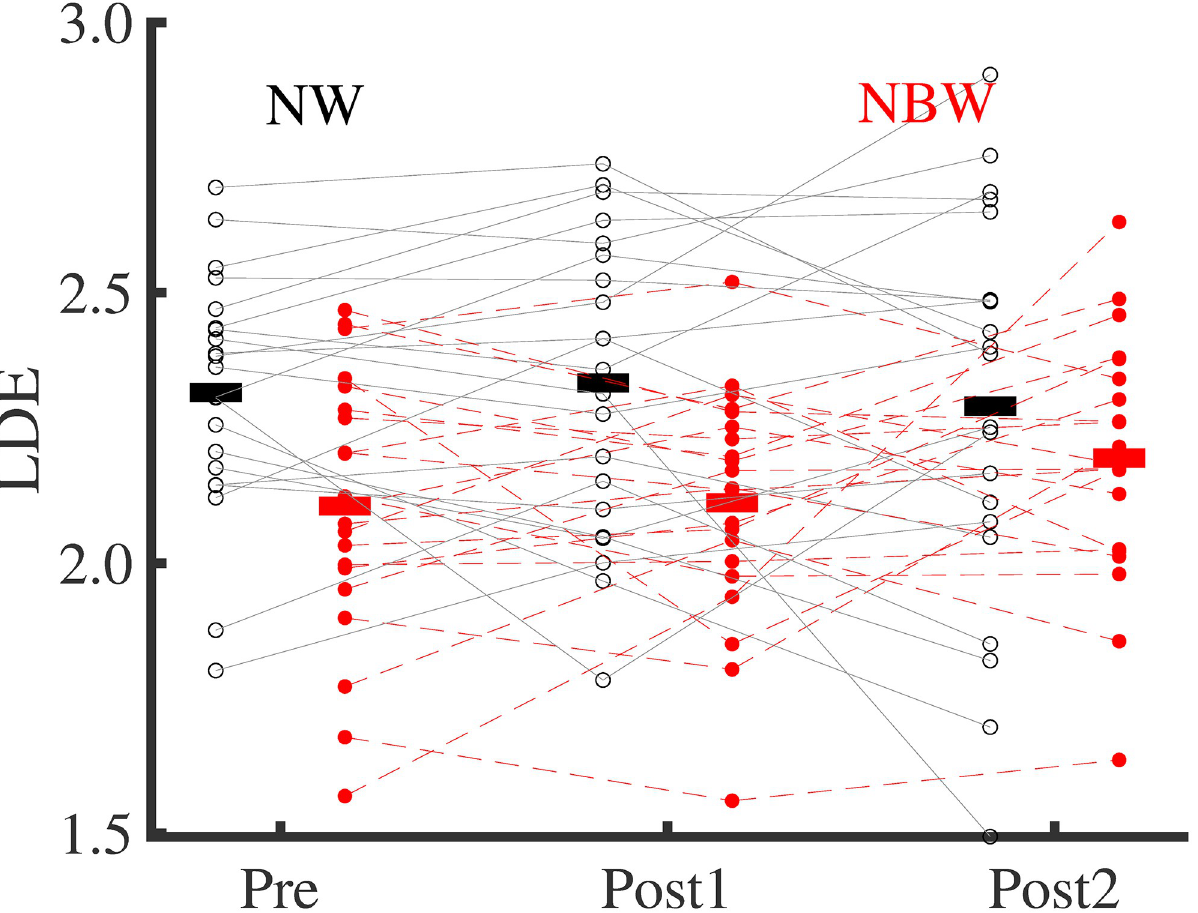
Fig 6. Local divergence exponents in narrow-base and normal walking at time-points Pre, Post1, and Post2. Thin lines represent individual subject data. Thick horizontal lines indicate means over subjects. Black, normal walking; red filled-dot, narrow-base walking.